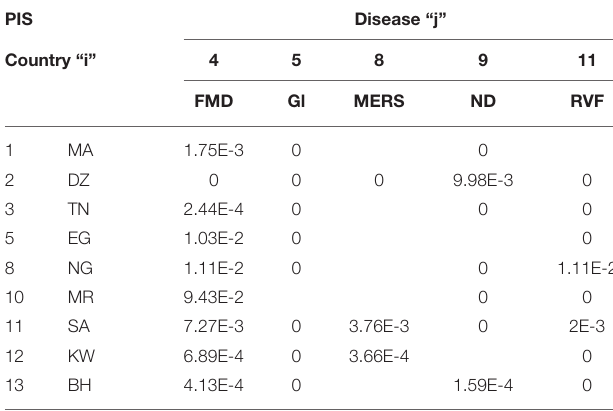
TABLE 6 | Probability of introduction of the j disease into the European Union through people movement from the country i . PIP Disease “j”